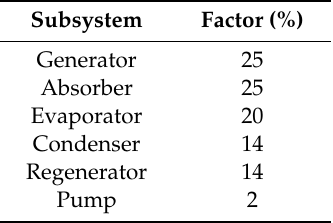
Table 1. Allocation of capital costs to each subsystem of the absorption refrigeration